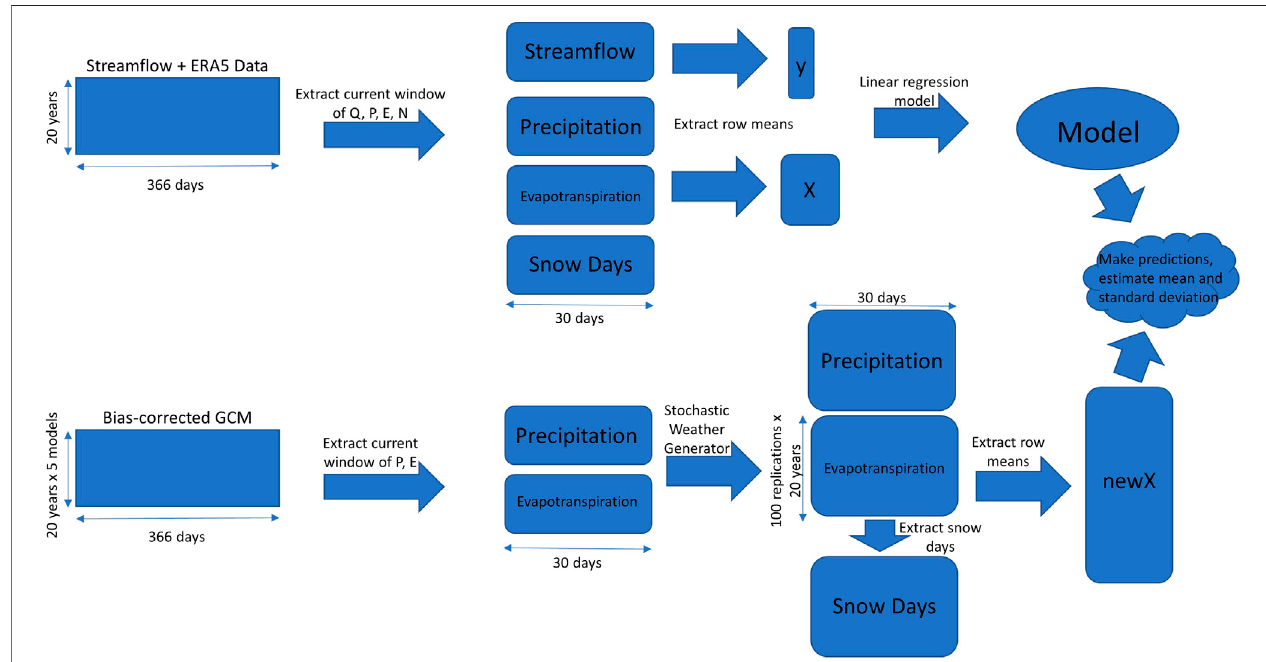
FIGURE 2 | Work fl ow of methods for making predictions for each stream fl ow station and each window. Boxes indicate data matrices of stream fl ow (Q), precipitation (P), evapotranspiration (E), or snow days (N). Each row of data represents a single year, and each column indicates a different day.